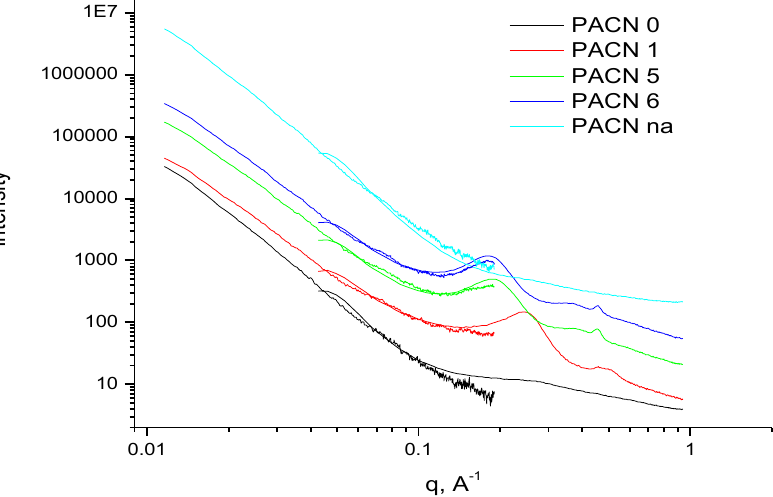
Figure 14. Overlay of the WAXS and SAXS patterns for PACN samples, showing PACN containing intercalated clays in PACN1, PACN5, and PACN6, as well as exfoliated clays in PACN0 and PAC- Nna.